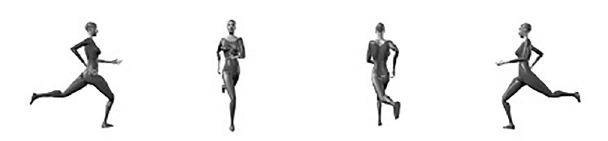
FIGURE 1 | A snapshot of a running action seen from 4 different viewpoints.